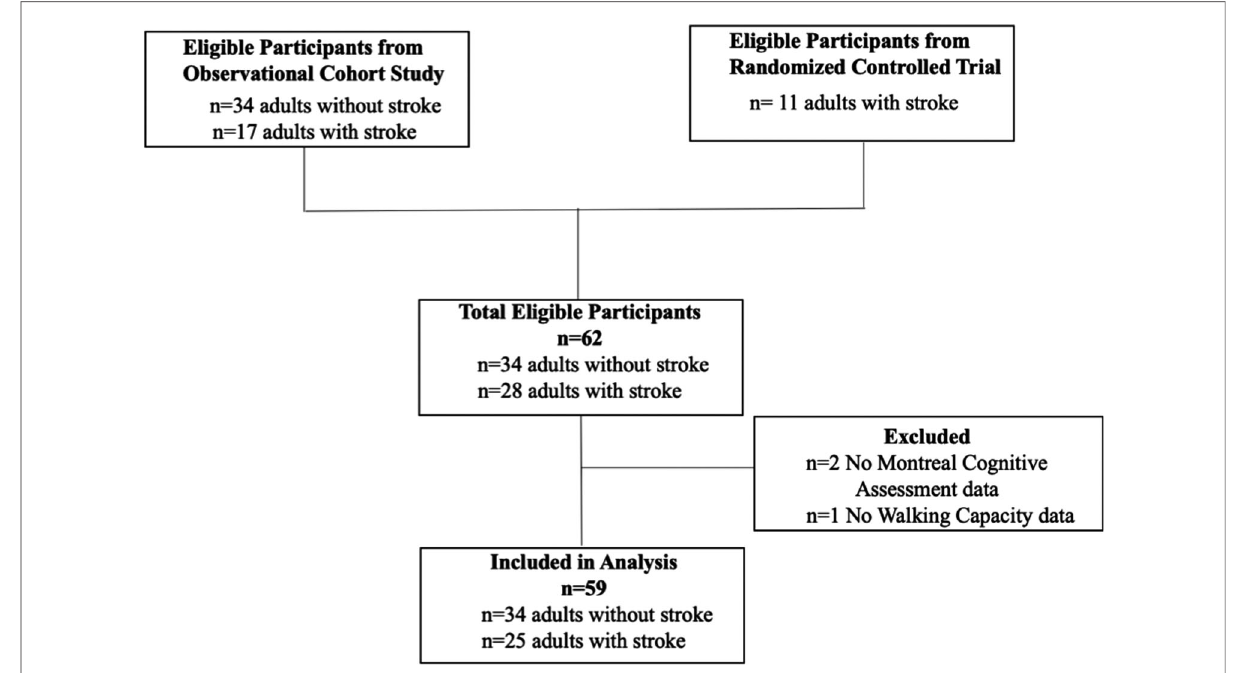
FIGURE 1 Participant fl ow through the